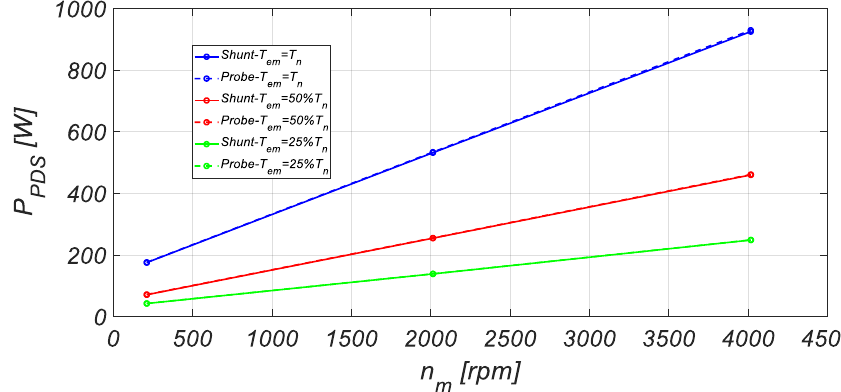
Figure 5. PDS input active power measured with the shunt resistor and fluke current probe at I d = −1 A.